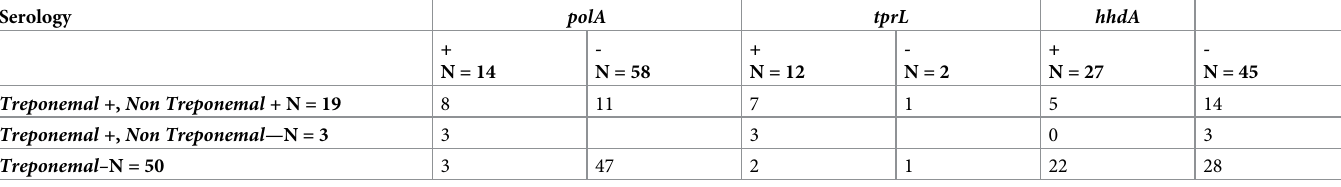
Note: For what concerns the PCR results of polA and hhdA: a total of 75 samples were collected, however the results presented do not tally due to invalid results in serology or because samples containing inhibitors were not tested by